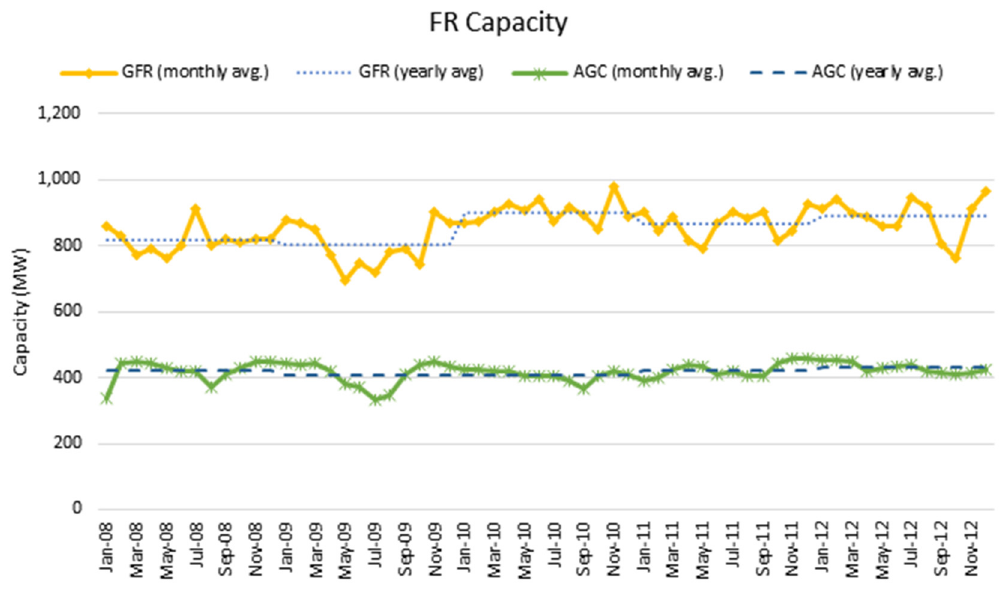
Figure 1. The capacity of frequency